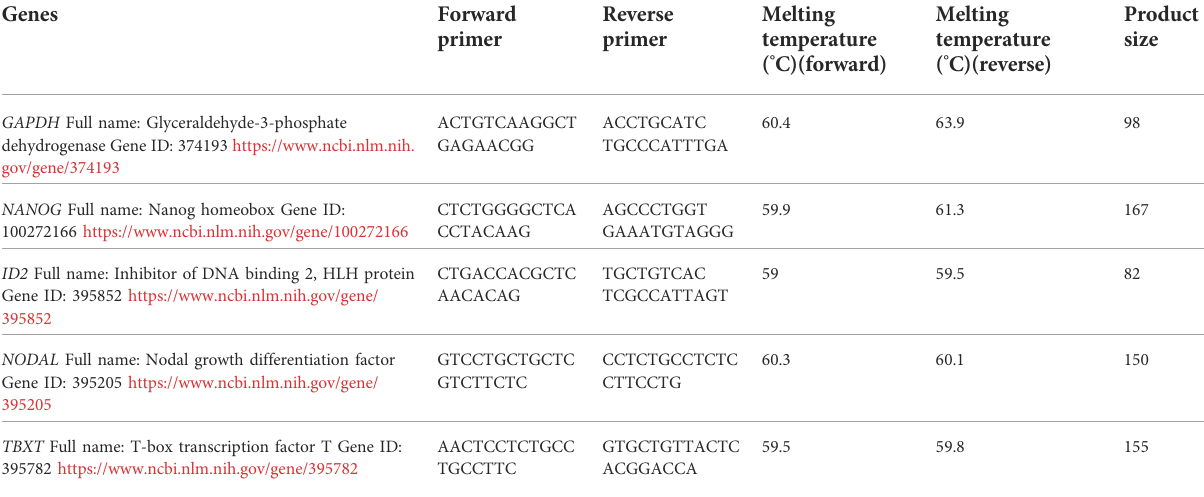
TABLE 2 List of primers used for